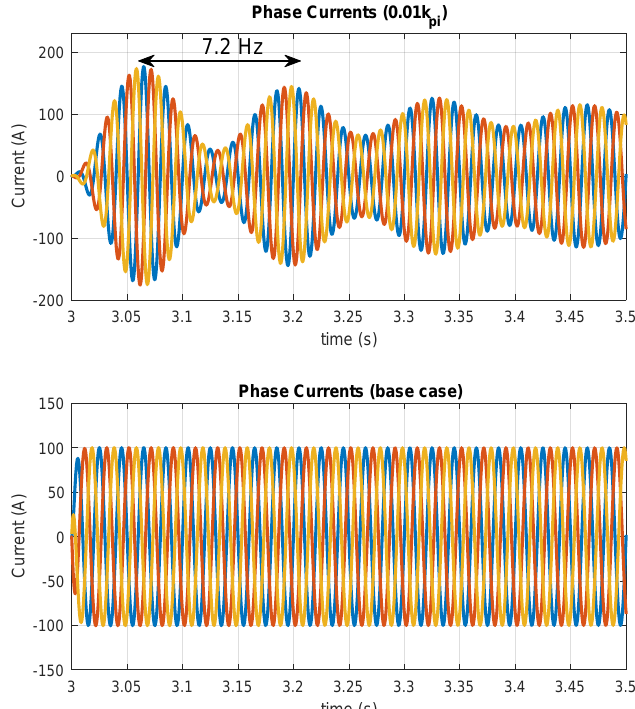
Figure 12. ( Top plot ) time domain plot of phase currents in abc frame, showing sustained resonances for the case with 0.01 × k pi with a matching frequency with that of frequency response; ( Bottom plot ) base case with no